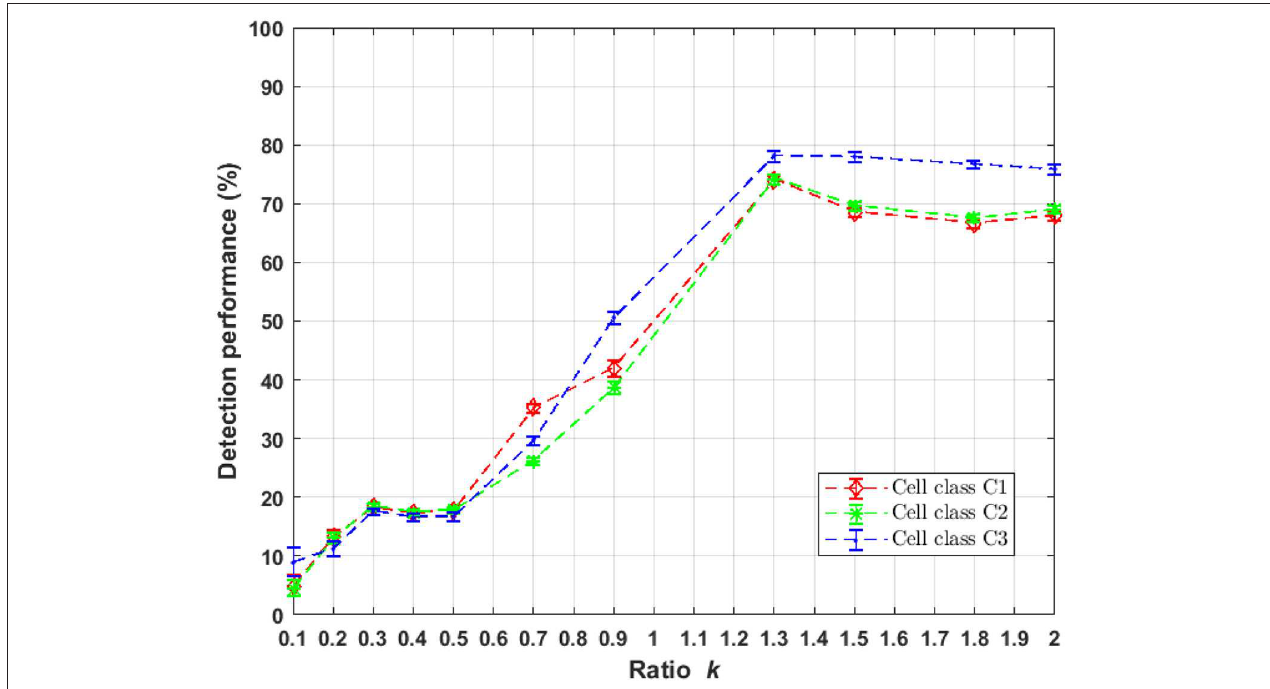
FIGURE 4 | Performance of markers localization using UNLOC in randomly and clustered distribution as a function of parameter k of Equation (1). UNLOC is more efficient in the range k = [1.3 2].